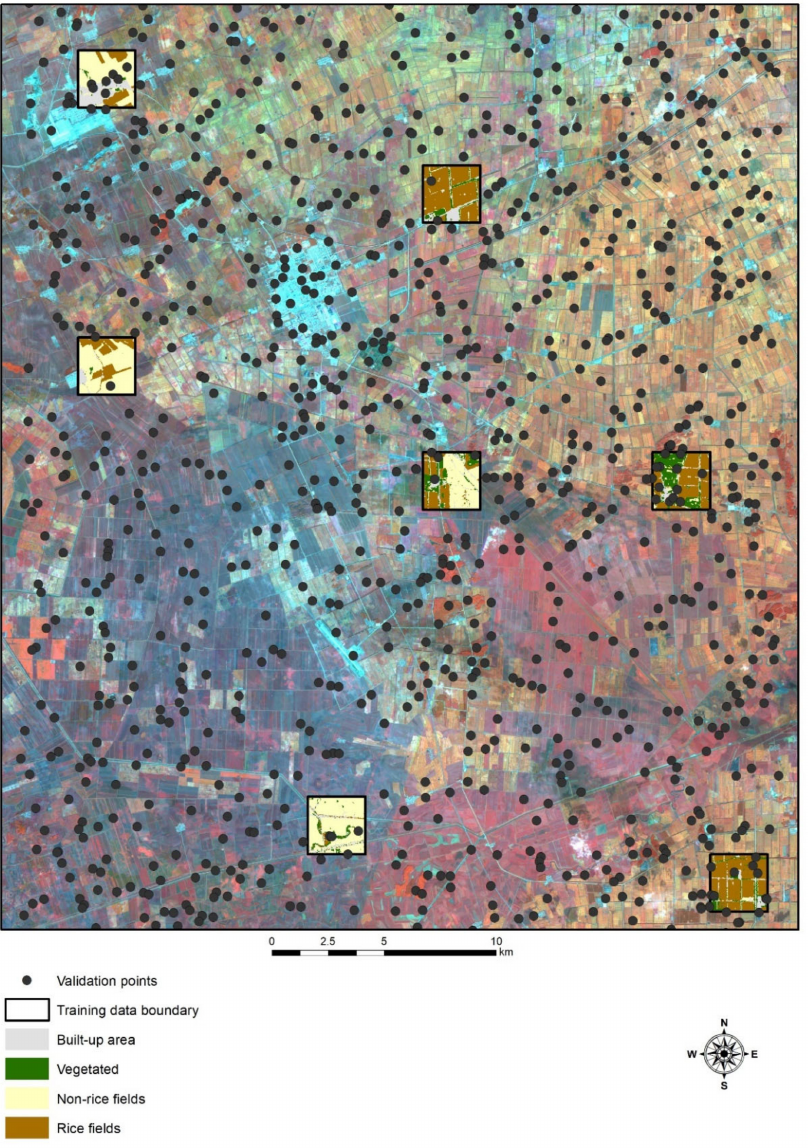
Figure 3. Map showing the distribution of training polygons and validation points used for random forest classification and accuracy assessment. The validation points were also used to assess the accuracy of the DL